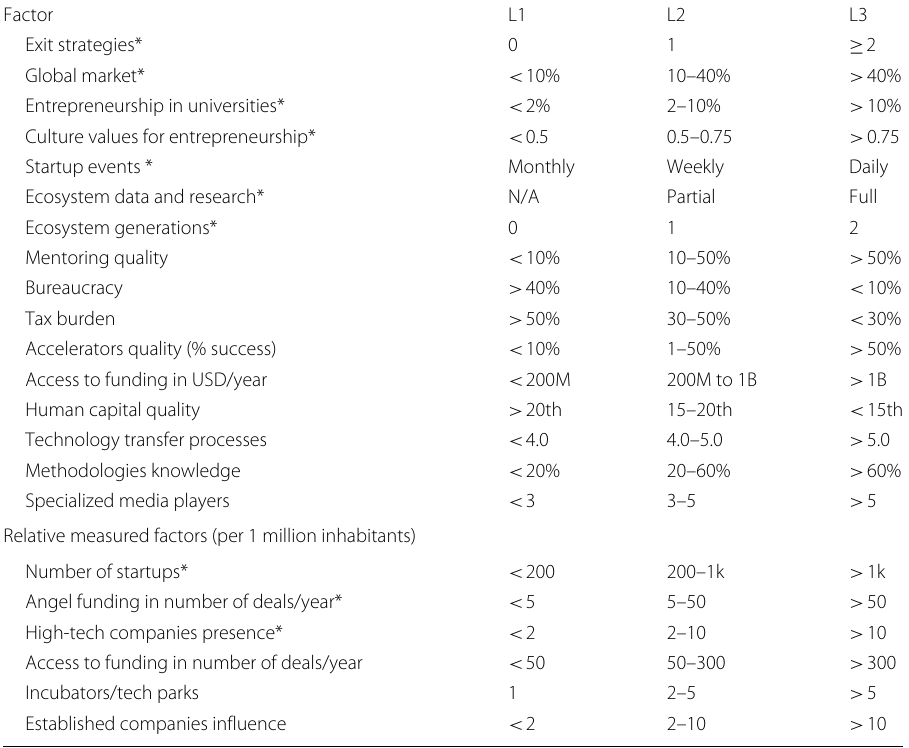
Table 2 Ecosystem maturity model factor classification: final version Factor